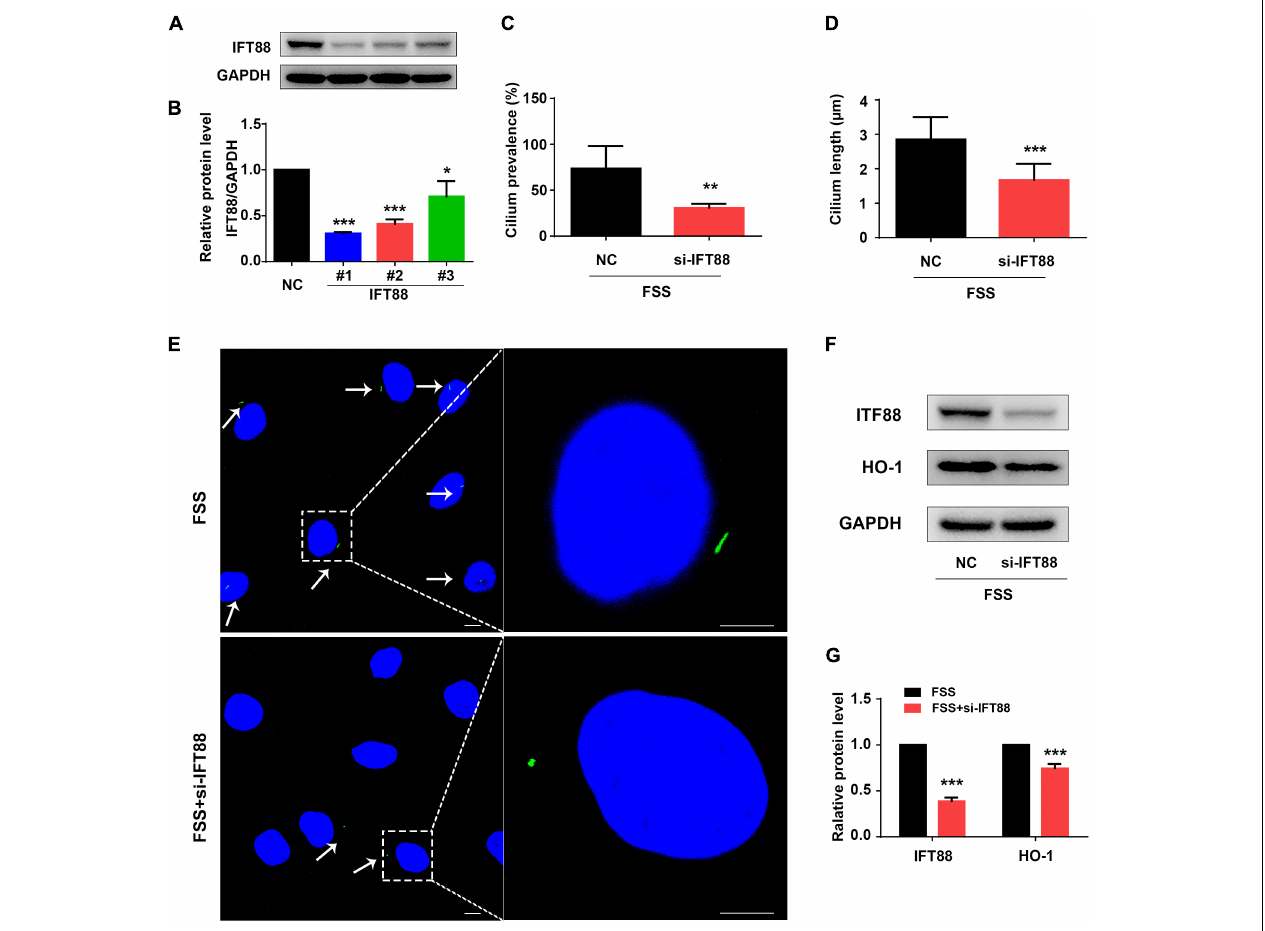
FIGURE 5 | Knockdown of IFT88 impairs cilium function and decreases expression of HO-1 in FSS-treated NP cells. (A) IFT88 Knockdown. NP cells were transfected with negative control siRNA (NC-siRNA) and three different IFT88-siRNA (#1, #2, #3). Then, cells were subjected to western blotting for expression of IFT88 (A) . Quantitative data from three independent experiments (B) . The #1 IFT88-siRNA was used for the following experiments in this study. (C,D) Qualification of cilium prevalence (C) and cilium length (D) in NP cells from three independent experiments. NP cells were transfected with negative control siRNA (NC-siRNA)